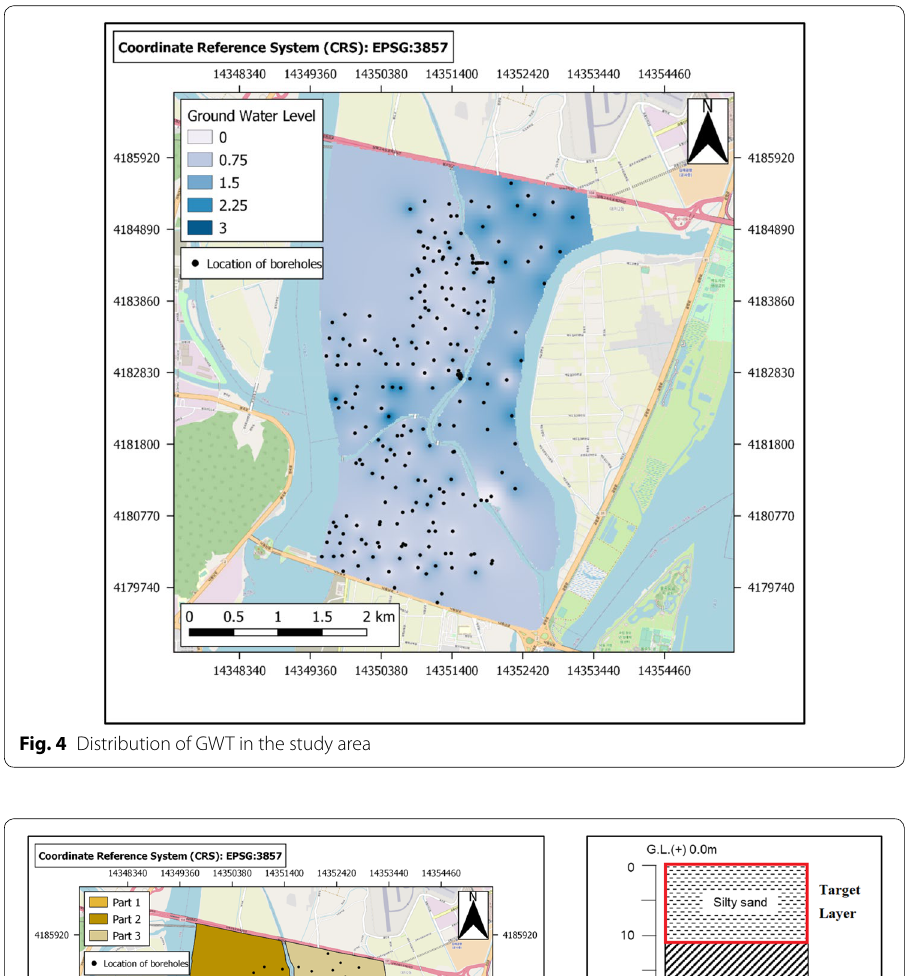
Fig. 4 Distribution of GWT in the study area